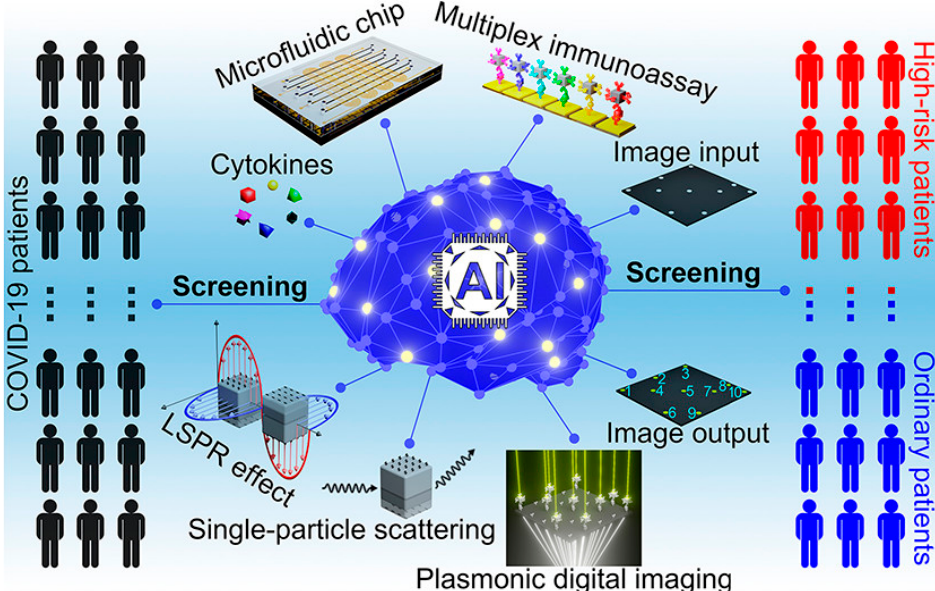
Figure 5. Schematic representation of the machine-learning-assisted micro fl uidic nanoplasmonic digital immunoassay for high-throughput, multiplex cytokine detection in COVID-19 patients. Reprinted with permission from [78]. Copyright (2021) ACS publications.